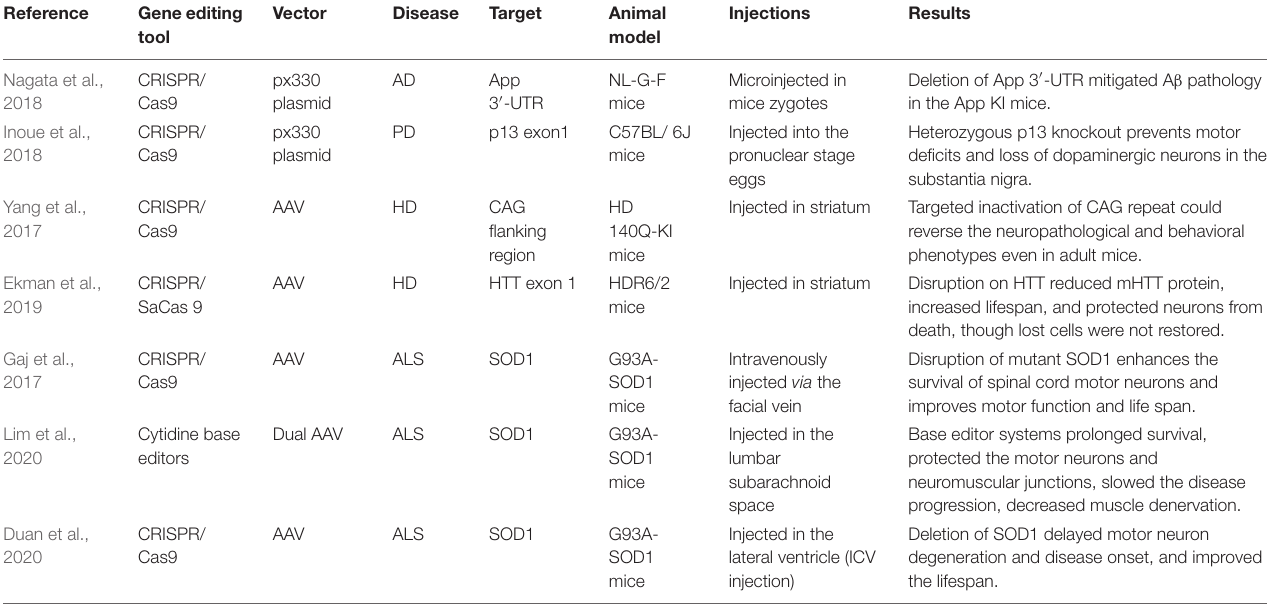
TABLE 1 | Pre-clinical studies of gene therapy in neurodegenerative